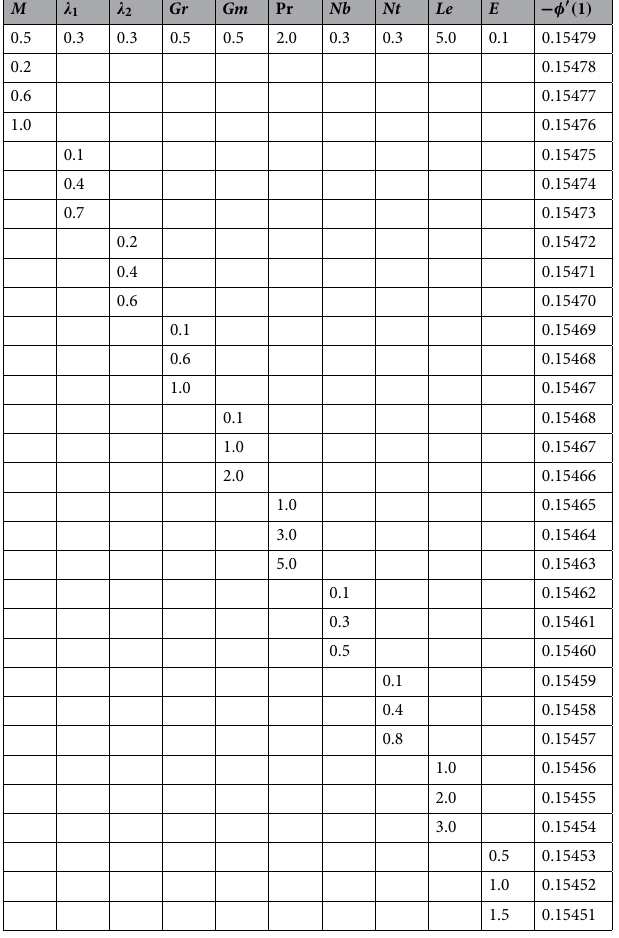
φ ′ ( 1 ) for E , (cid:31) 1 , (cid:31) 2 , Gr , Gm , Pr, Nb , Nt , Le and E . −